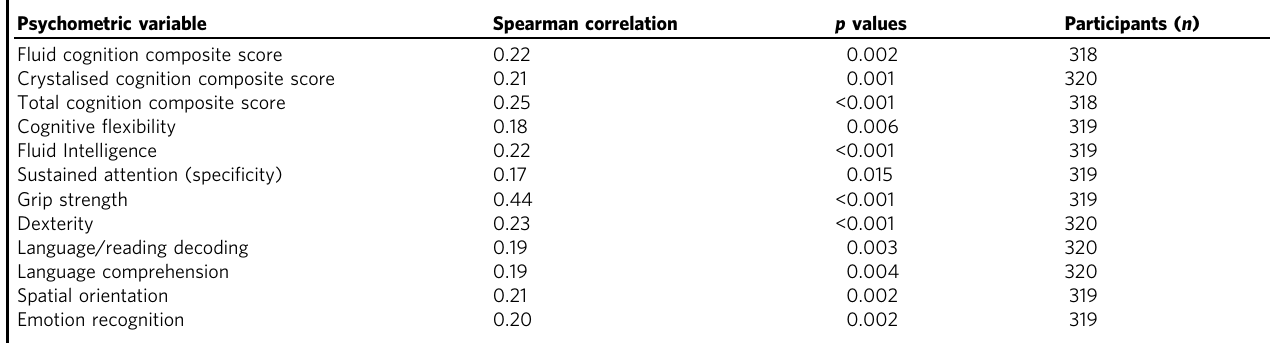
Table 1 Results for psychometric prediction.